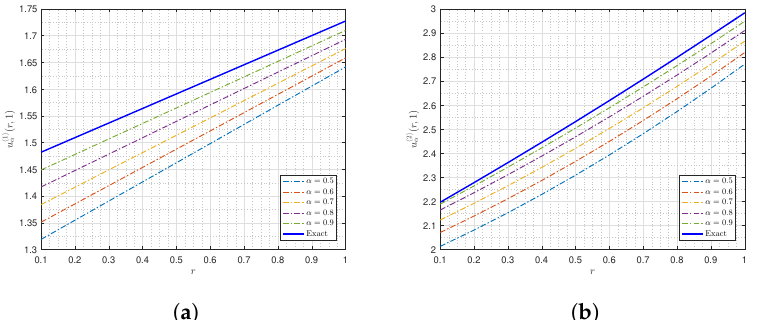
(cid:104) 1 (cid:105) ( r ,1 ) and u (cid:104) 2 (cid:105) ( r ,1 ) in Examples 3 and 4. α α ( r ,1 ) α